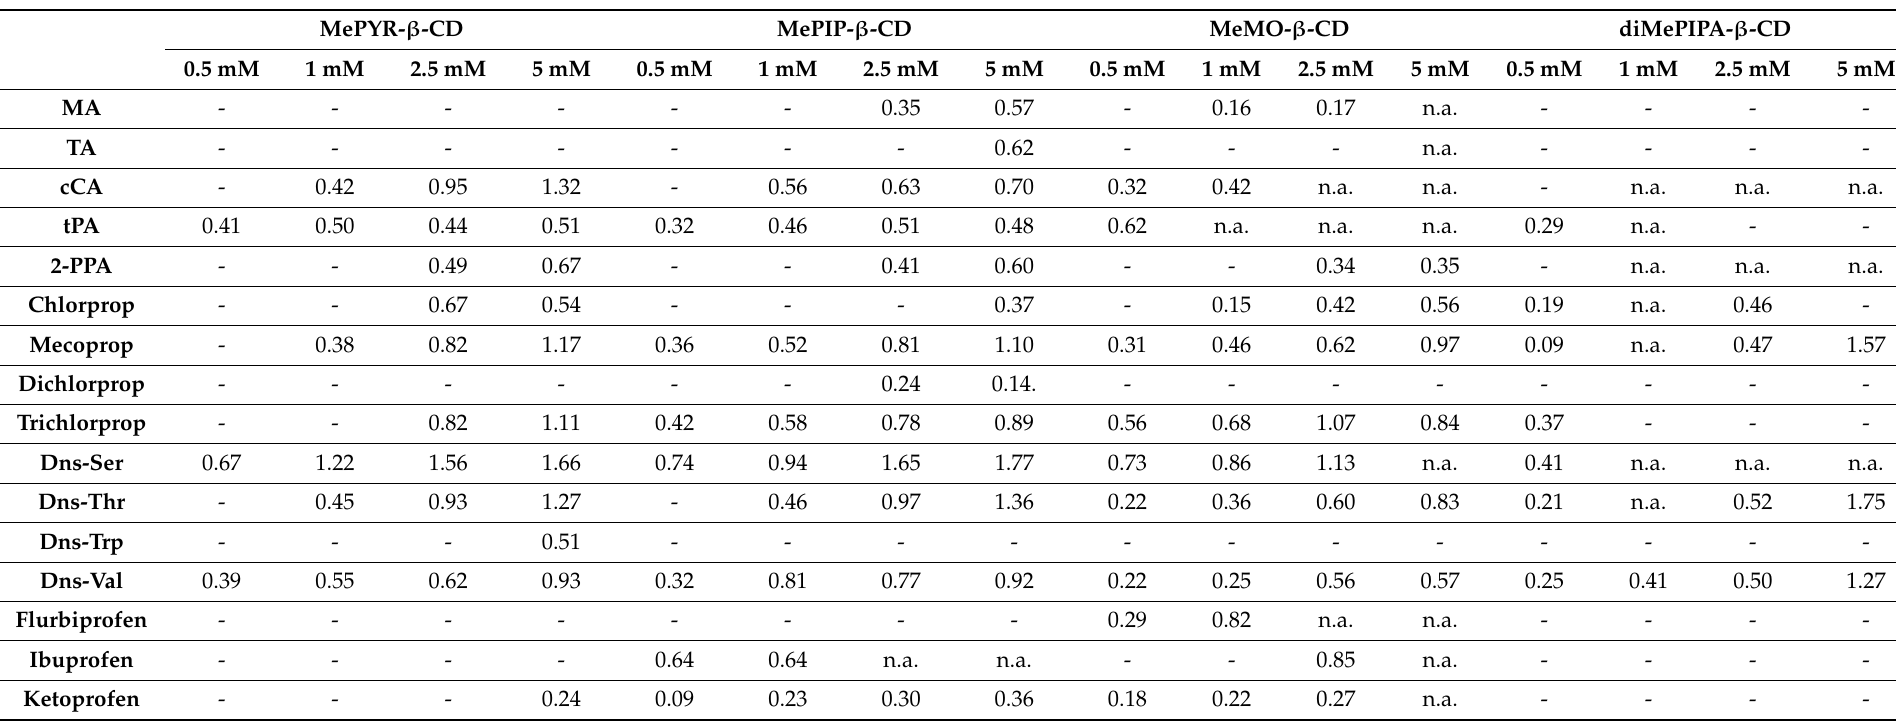
Table 3. Chiral separations of the tested model racemates with the four permanently positively charged N -heterocyclic CD derivatives (second set) at pH 6.0, indicating the maximum resolution values ( Rs